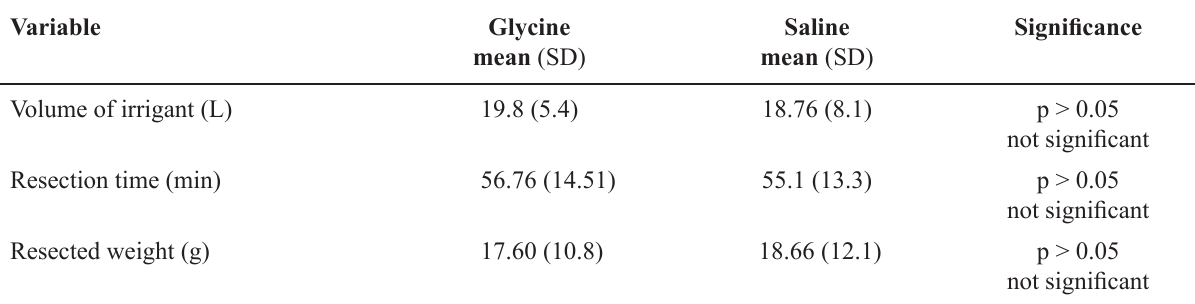
Table 3 – Comparison of intraoperative variables between bipolar and monopolar groups.